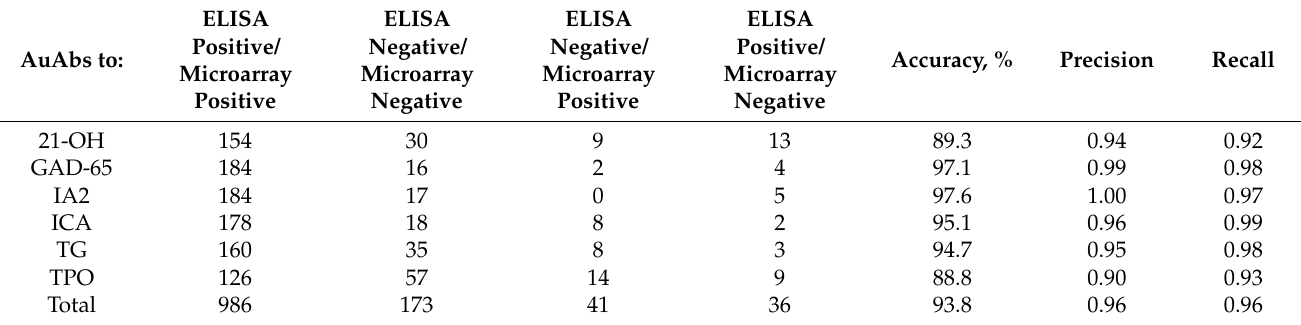
Comparison of the accuracy of the microarray-based assay with ELISA for the detection of organ-specific